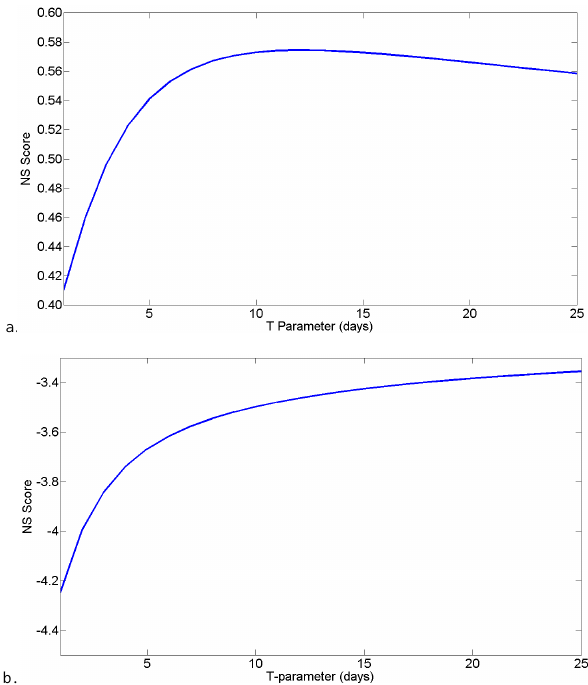
Figure 11 . Scatter plots of observed near-surface SWI and SMOS surface SWI for (a) Oklahoma and (b) Nebraska stations. Scatter points are color coded by individual stations.